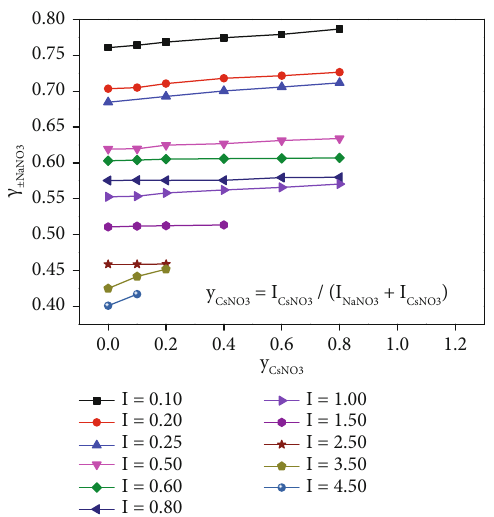
Figure 2: A plot of the mean activity coe ffi cients of NaNO mole fractions in the